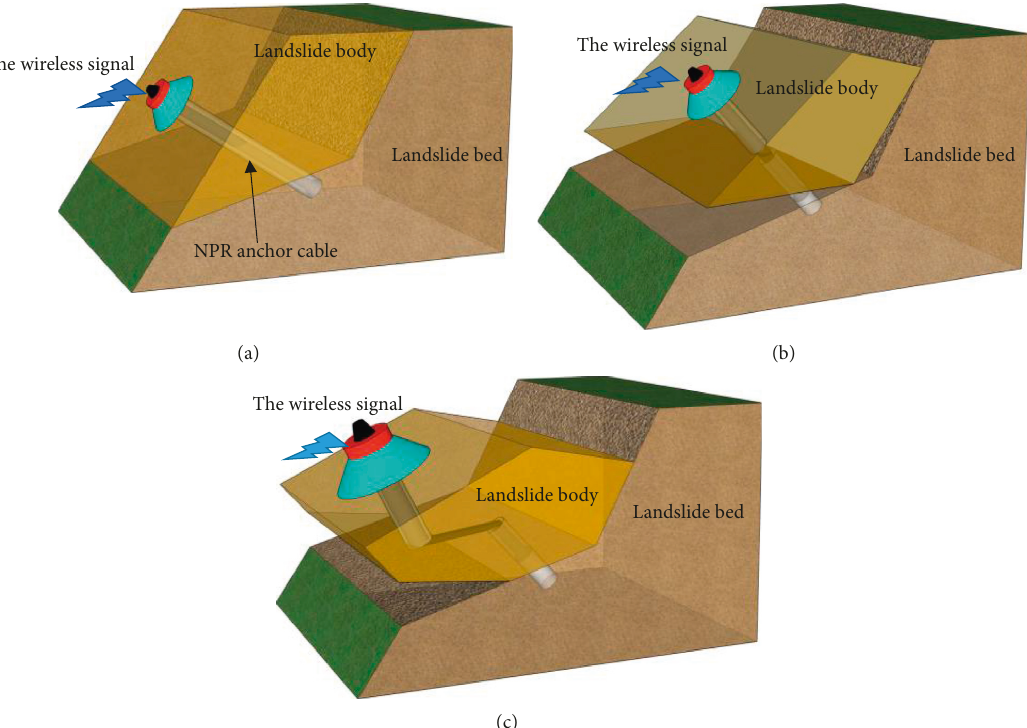
Figure 12: Process of interaction between NPR anchor and slope: (a) before the slope slides; (b) slope sliding; (c) after the slope